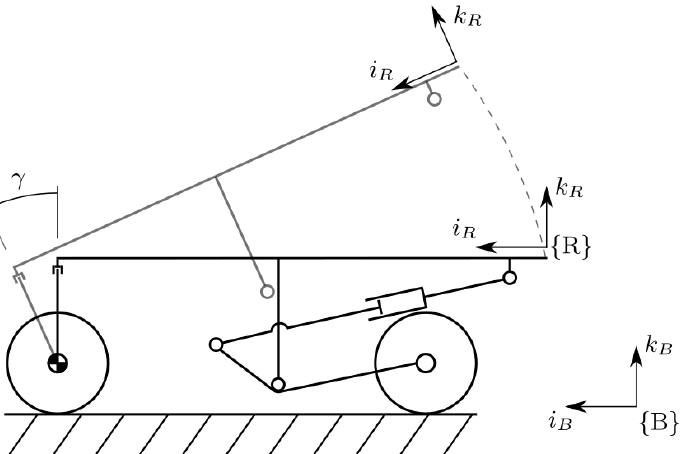
Figure 4. Pitch motion of the mobile base that causes the motion of { R } , described, for simplicity, with a relative yaw angle δ = 0. In black is the start position of the base, in gray is the new configuration. It is worth noting that it is a planar motion in the { ˆ i B , ˆ k B }